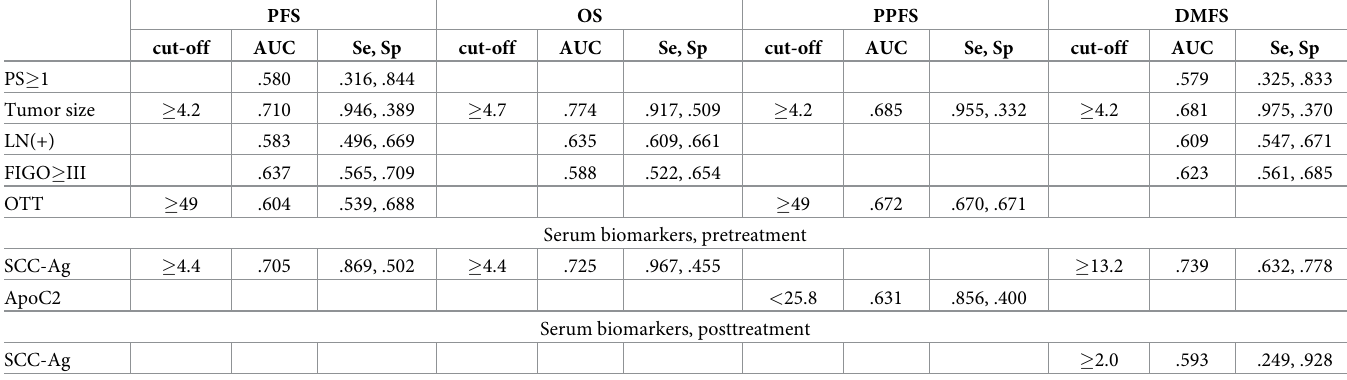
Table 3. Results of time-dependent ROC analysis for significant variables in univariate Cox proportional hazard